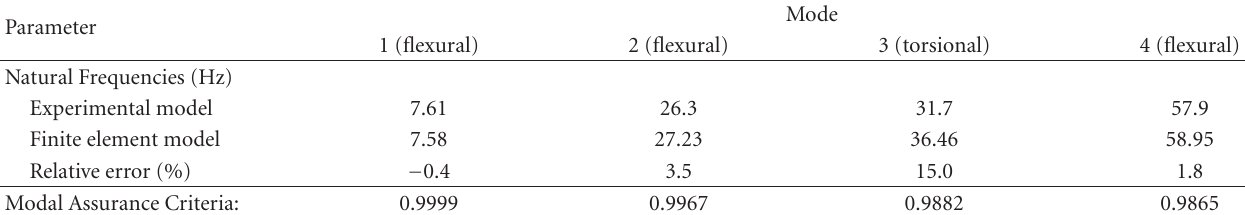
Table 1: Comparison of FE and experimental natural frequencies and mode shapes for the undamaged system.